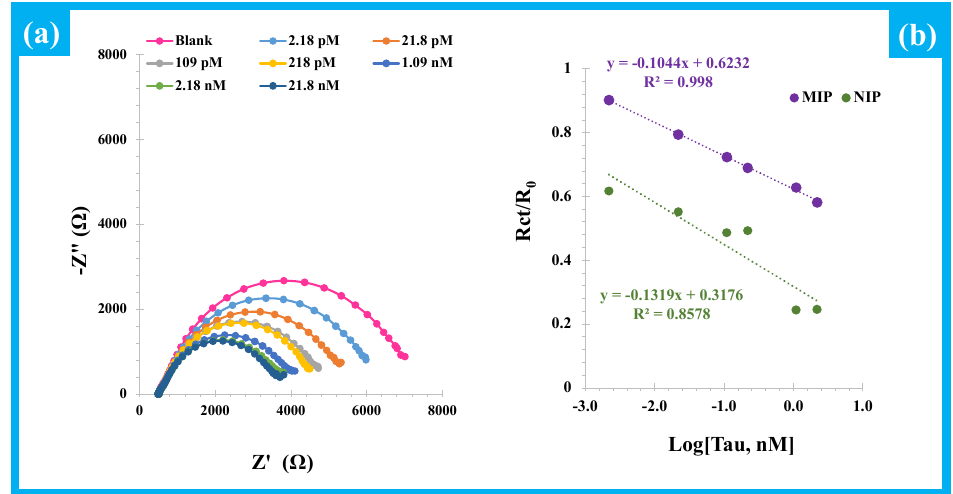
Figure 4. ( a ) EIS measurements of MIPs and ( b ) the corresponding calibration curves of MIP (purple) and NIP (green) in 5.0 mM [Fe(CN) 6 ] 3 − and 5.0 mM [Fe(CN) 6 ] 4 − , in PBS buffer pH 5.6, with different concentrations of Tau protein.